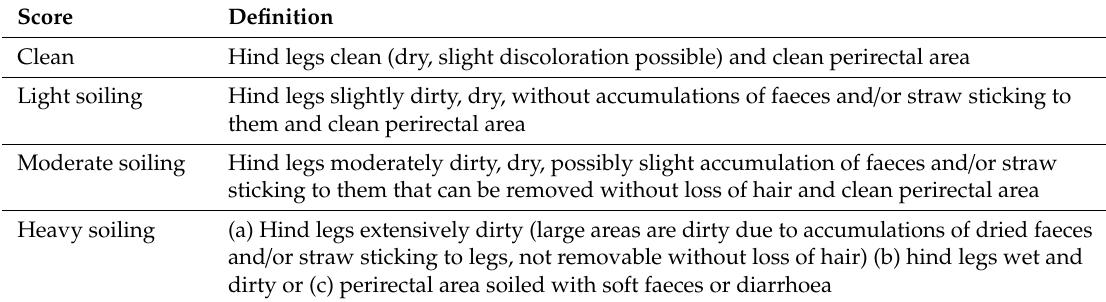
Table 1. Definitions of the soiling score for the examination of individual rabbits at the age of 82 days (see also Tillmann et al.